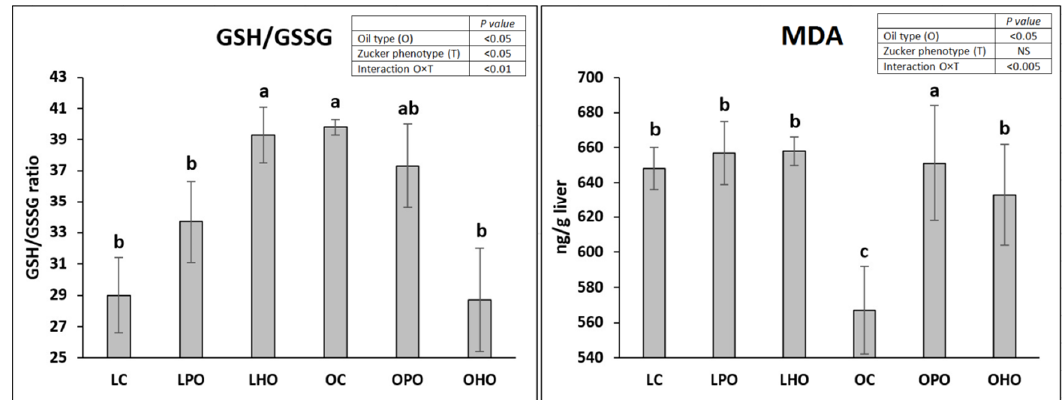
Figure 2. Liver antioxidant status in Zucker rats fed experimental diets. Values are the mean ±